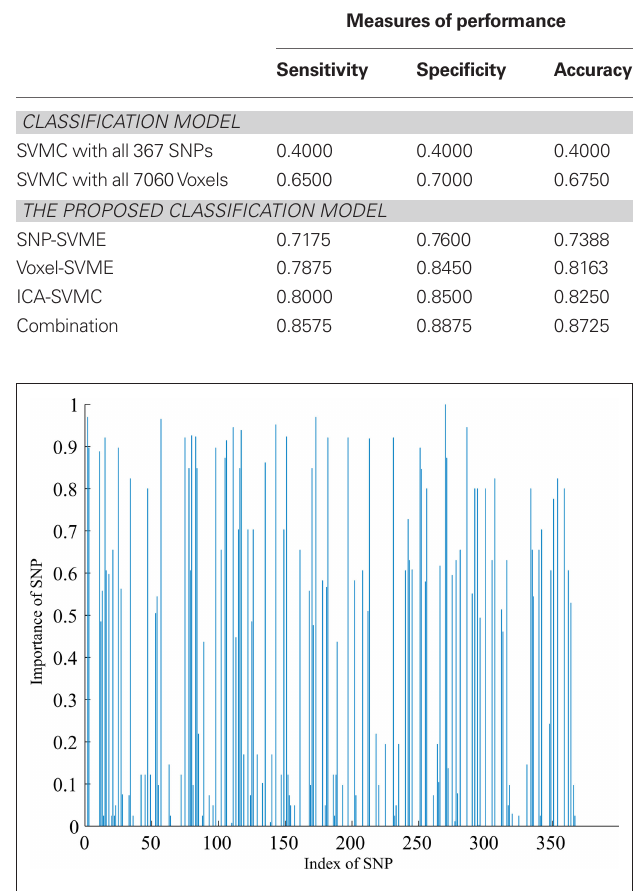
Figure 2 | importance of individual